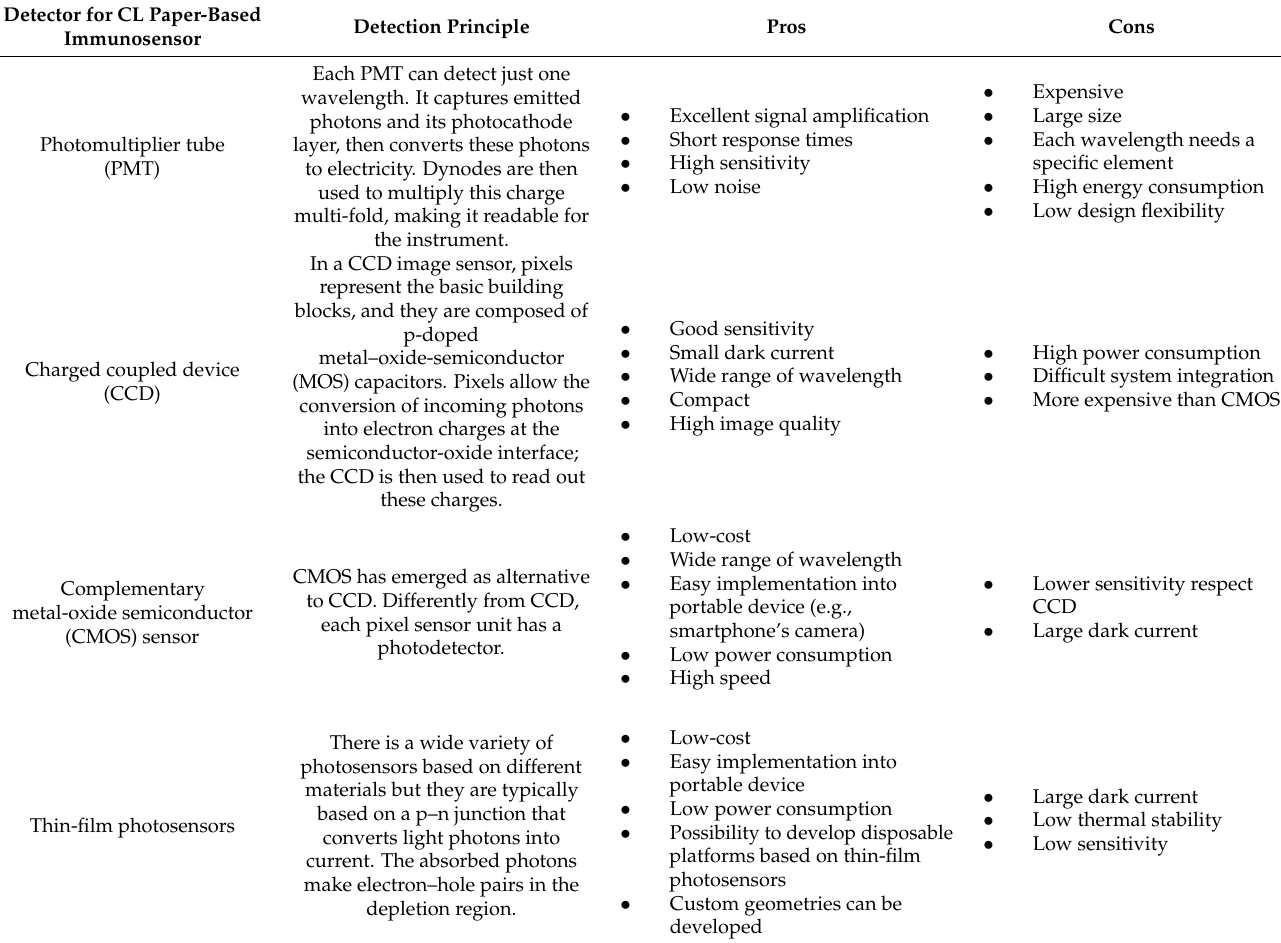
Table 2. Technologies for CL detectors implemented into paper-based portable